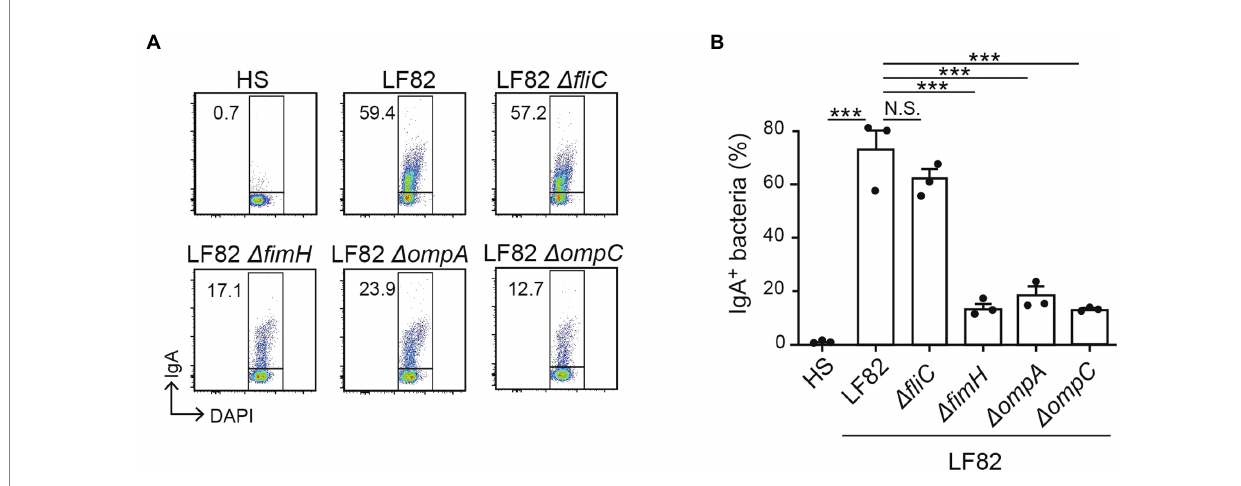
FIGURE 4 LF82-specific IgA recognizes molecules associated with its pathogenicity. The reactivity of IgA from LF82-infected mice to several LF82-derived mutants ( ∆ fliC , ∆ fimH , ∆ ompA , and ∆ ompC ) was analyzed by flow cytometry. (A) Representative flow cytometry plots and (B) percentages of IgA- bound bacteria. Data shown are mean ± SD ( N = 3). N.S., not significant; ***, p < 0.001 by Dunnett’s test (vs.